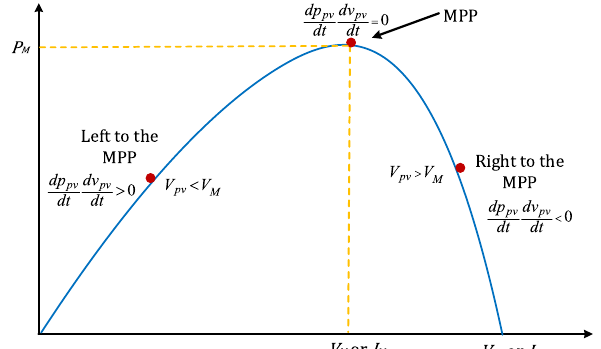
Figure 1. P–V characteristics curve of PV panel.